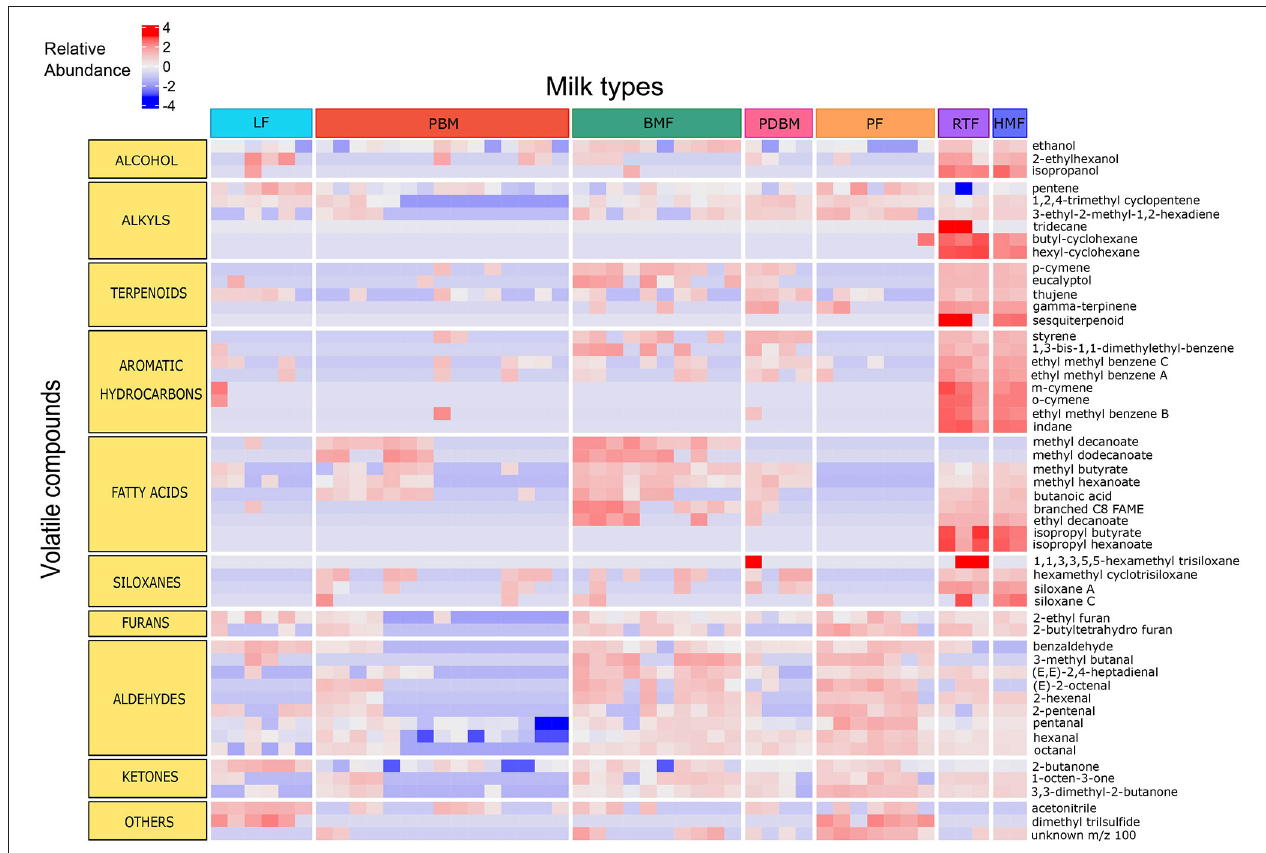
FIGURE 1 | Relative abundance of compounds significantly different across milk types. Compounds represented in rows and samples represented in columns. Data are log-transformed and color scale indicates intensity of relative abundance of a compound. Positive values (red) represent high abundance, negative values (blue) represent low abundance, and zero represents moderate abundance. LF, Liquid Formula; PBM, Preterm breastmilk; BMF, Bovine milk-based fortified breastmilk; PDBM, Pasteurized donor breastmilk; PF, Powder Formula; RTF, Human milk-based Ready-To-Feed formula; HMF, Human-milk based fortified breastmilk.